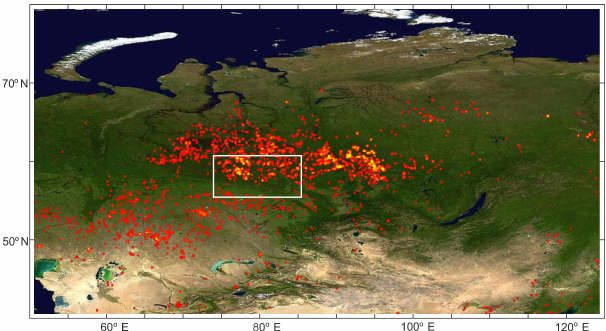
Figure 1. Interannual variations in average July temperatures and the amount of precipitation according to data from the Tomsk me- teorological station, as well as interannual variations in total carbon monoxide content according to satellite observations over the terri- tory of Tomsk (http://giovanni.sci.gsfc.nasa.gov/).